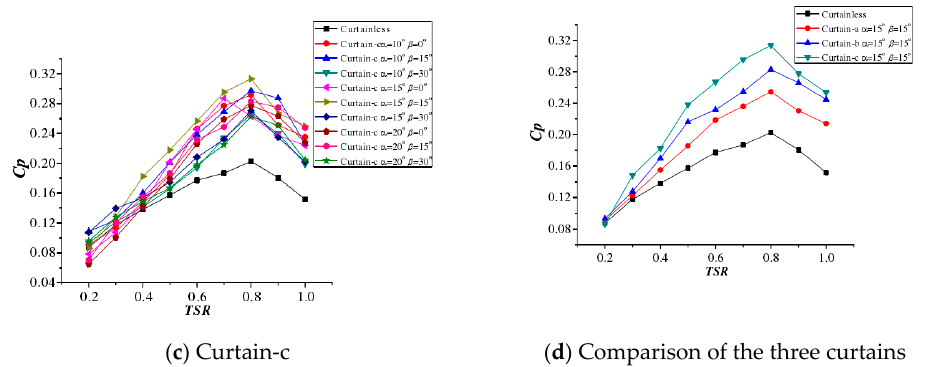
Figure 18. Variation of the power coefficient with the TSR for ( a ) Curtain-a, ( b ) Curtain-b ( c ) Curtain-c as well as the ( d ) comparison of the three curtains ( U = 10 m/s).